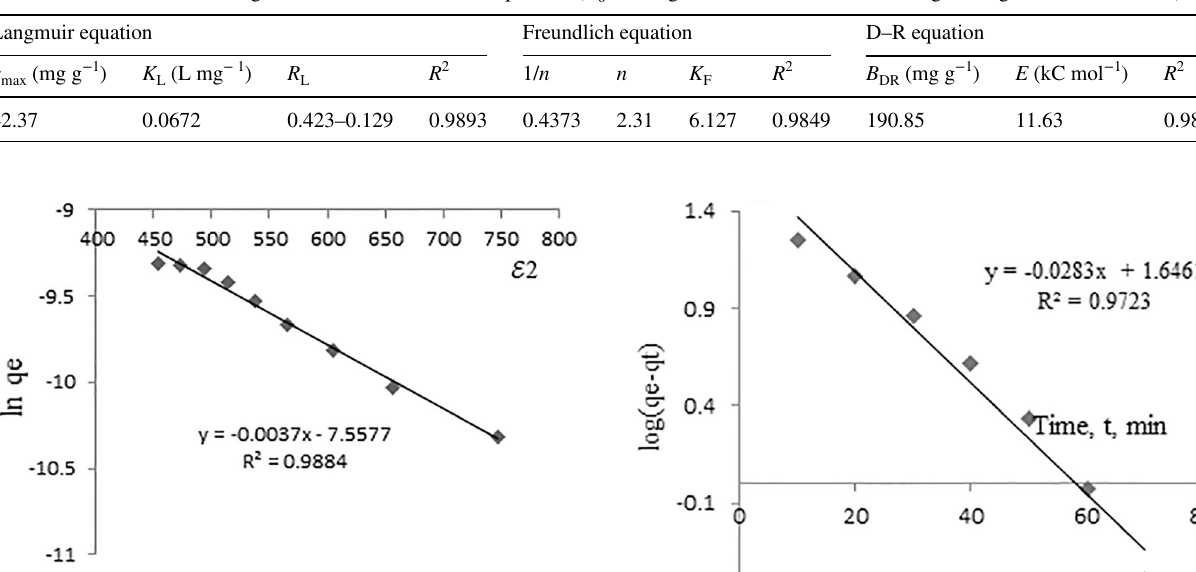
−1 , V = 0.04 L, sorbent dosage 1.25 g L −1 , 30 min, 20 °C) 0 = 50 mg L